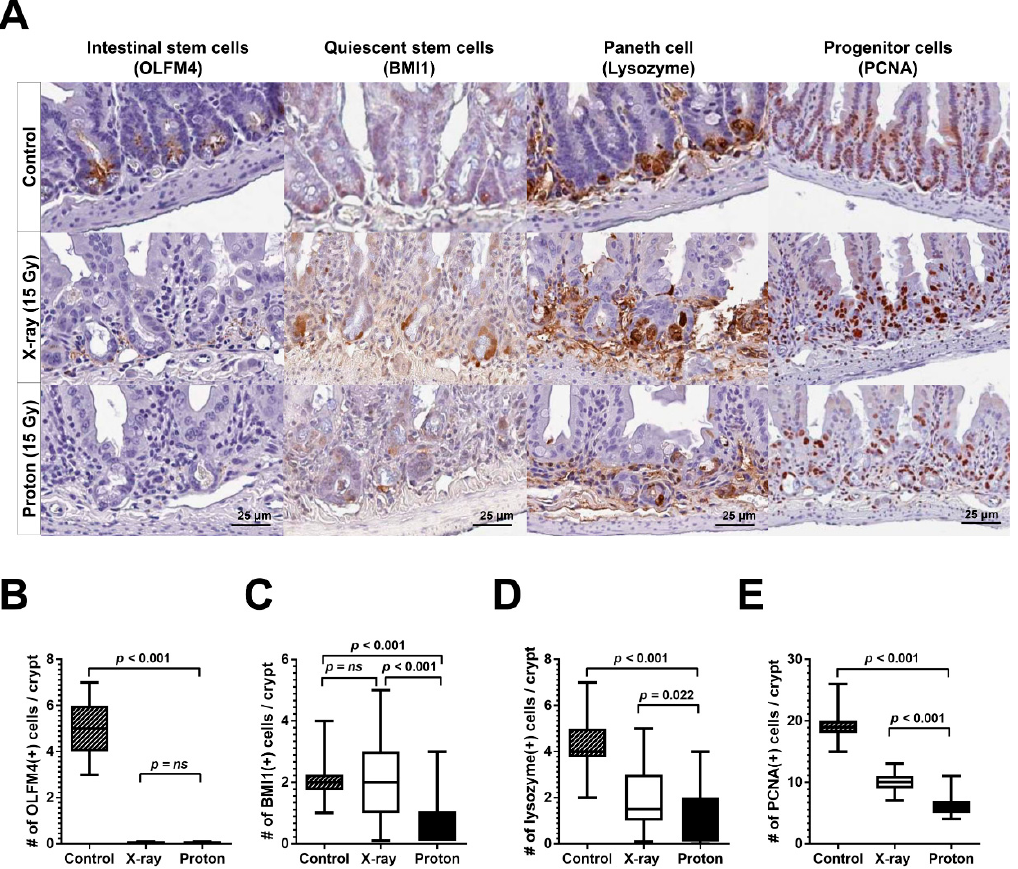
Figure 4. Proton irradiation decreases the population of quiescent stem cells and Paneth cells within the mouse jejunal crypts to a greater extent than X-ray irradiation. ( A ) The representative immunohistochemistry (IHC) results for OLFM4, BMI1, lysozyme, and proliferative cell nuclear antigen (PCNA) in the intestinal crypts 3.5 days postirradiation with 15 Gy of X-ray or proton irradiation are presented herein. The box-and-whisker plots representing distributions of OLFM4-positive ( B ), BMI1-positive ( C ), lysozyme-positive ( D ), and PCNA-positive cells ( E ) within the crypts 3.5 days postirradiation with X-ray or protons.